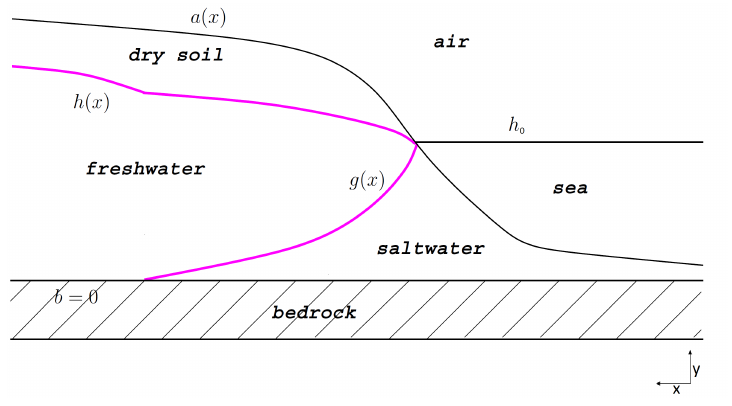
Figure 4. Schematic representation of the computational domain adapted from